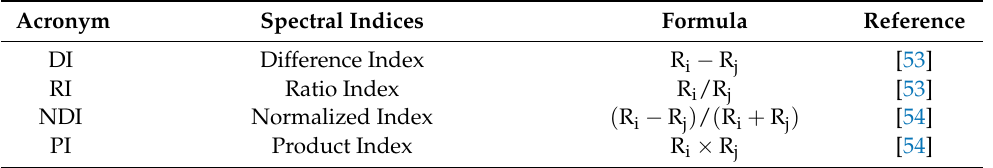
Table 2. Reference overview of studies of spectral indices and